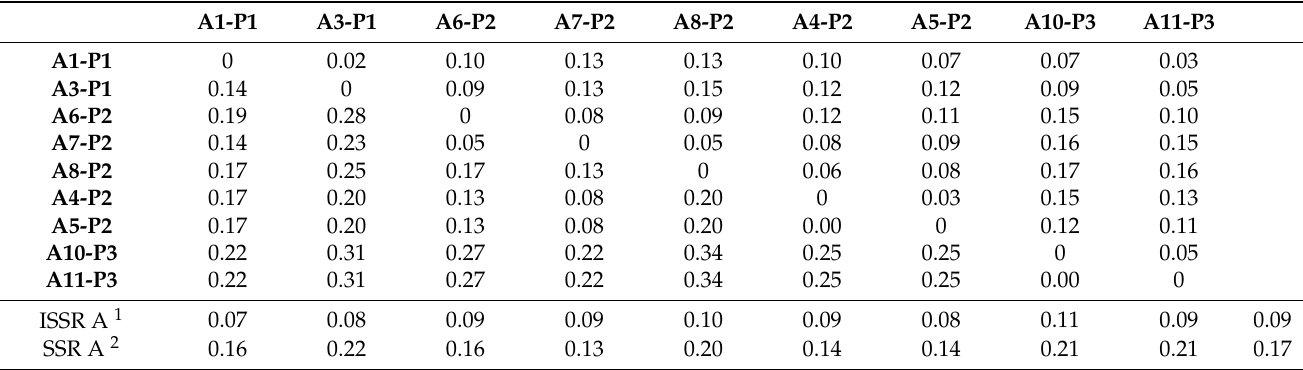
Table 3. Genetic dissimilarity values between pairs of individuals from the different Hancornia speciosa donor plants using the complement of Jaccard and weighted indexes for ISSR (above the diagonal) and SSR markers (under the diagonal), respectively.